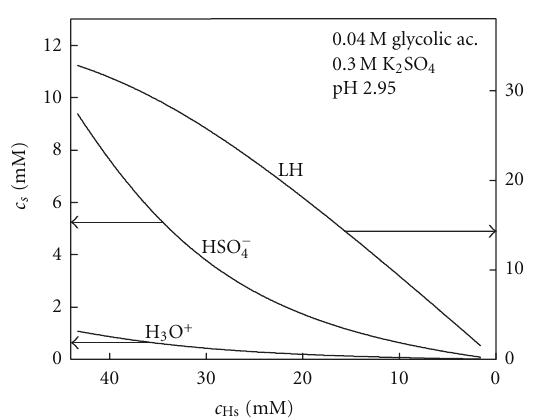
Figure 7: Distribution of proton donors at the electrode surface during the electrolysis of 0.04 M glycolic acid solution. Cathodic current density increases from left to right.